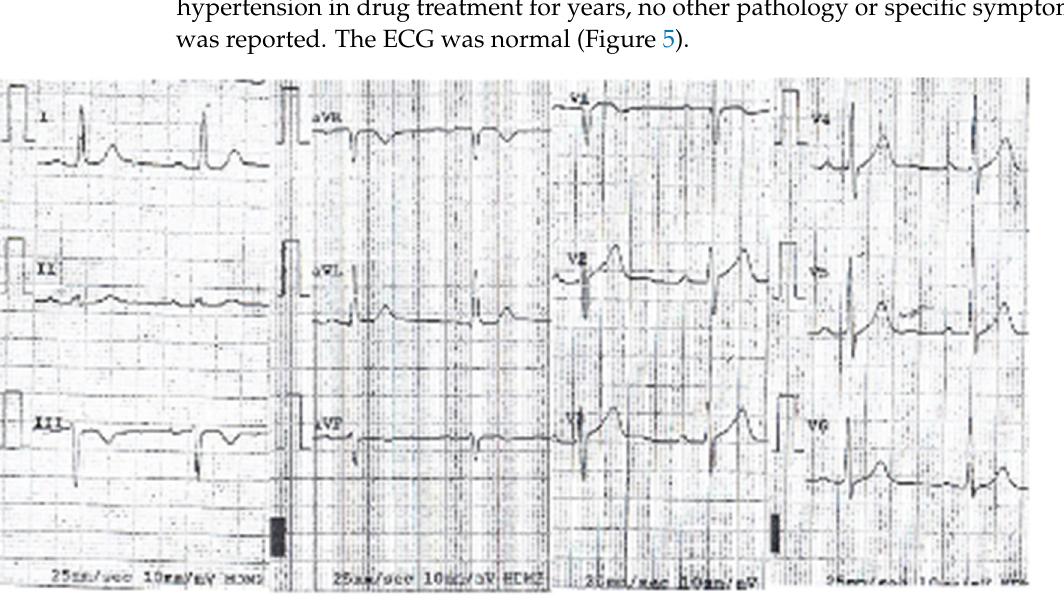
Figure 5. Proband’s father ECG tracing showing a normal sinus rhythm, without signs of atrio- ventricular or bundle branch